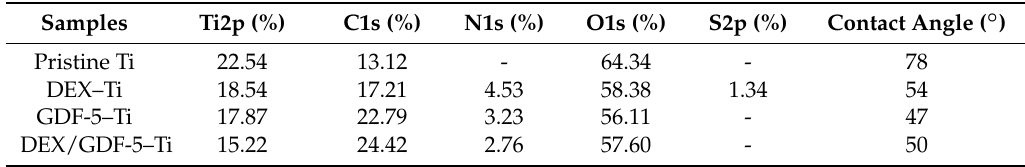
Table 1. Percentages of Ti2p, C1s, N1s, O1s and S2p on pristine Ti, DEX–Ti, GDF-5–Ti and